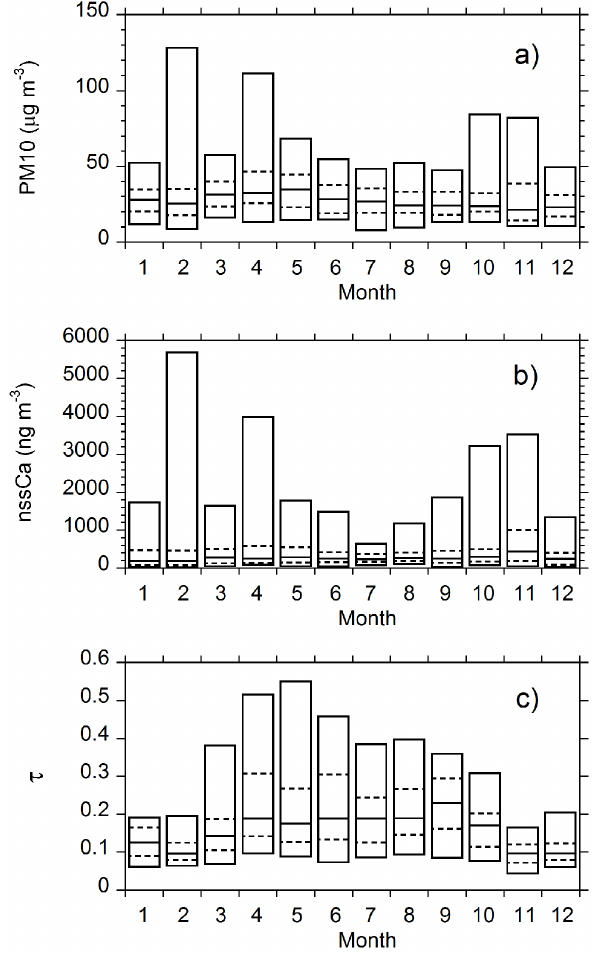
Fig. 5. Monthly distribution of PM 10 (a) , nssCa (b) , and τ (c) for the period June 2004–December 2010. The top and bottom of each box show the 5th and 95th percentiles. The middle line shows the me- dian value, and the dashed lines show the 25th and 75th percentiles.